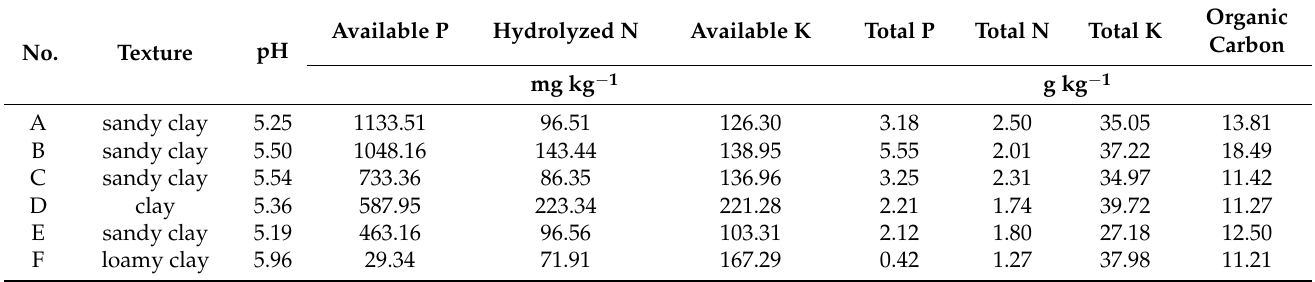
Table 1. Basic properties of the tested continuous-planting experiment